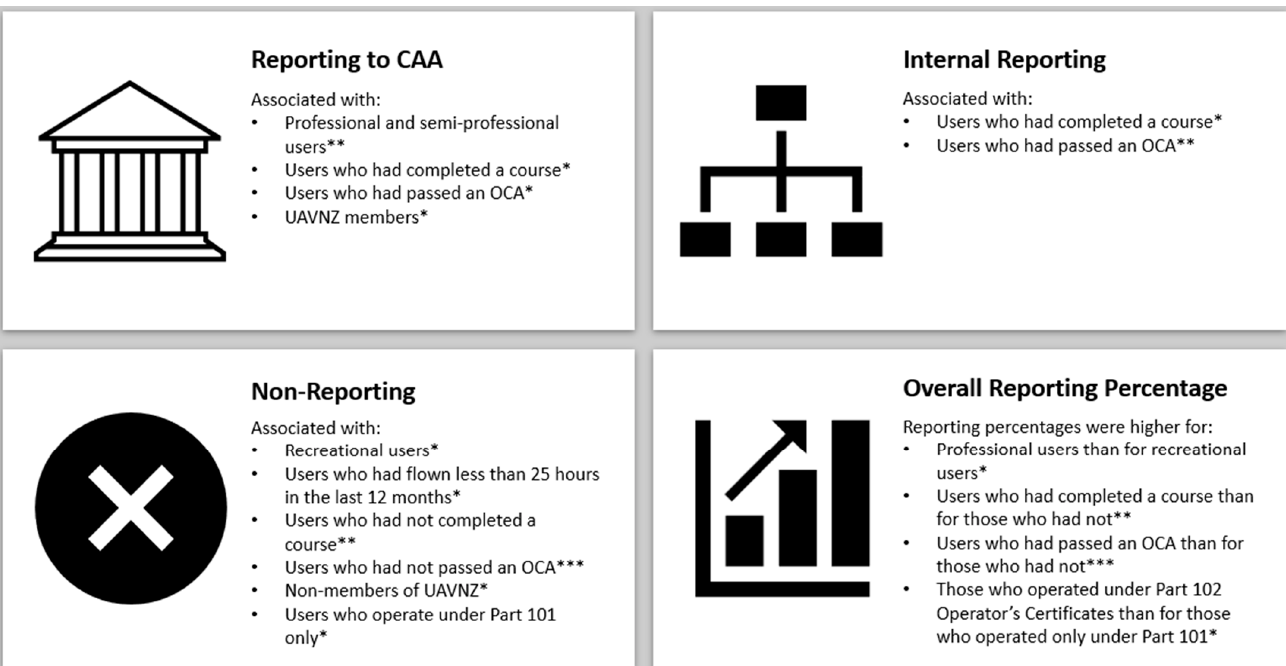
Figure 1. Abbreviated results of statistical analyses. Note: *, **, and *** indicate statistical significance